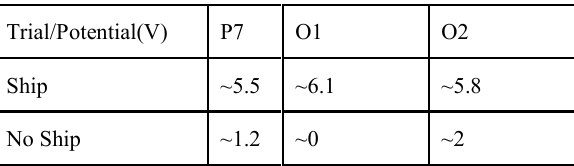
Table-5. Average P300 Peak Amplitude for our electrodes (P7,O1,O2)